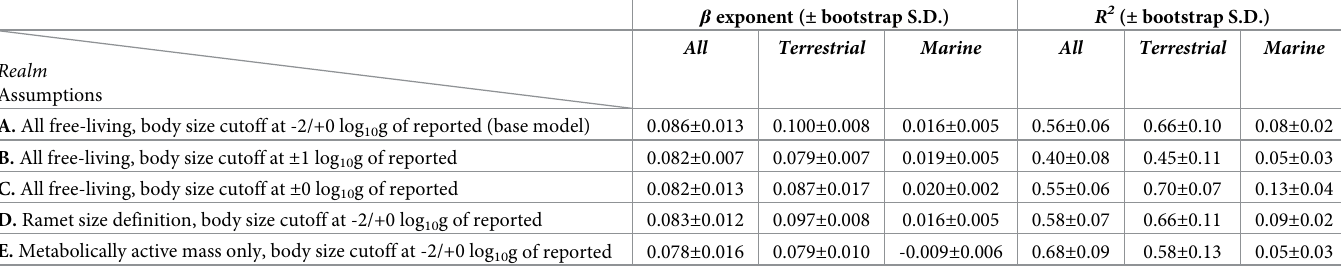
Table 5. Size-biomass power law exponents across realms and assumptions. Assumptions correspond to sensitive analyses plotted in S1 Fig. Exponents and R 2 result from 1000 bootstrapped linear regressions of log biomass on log size. β exponent ( ± bootstrap S.D.) R 2 ( ± bootstrap S.D.)